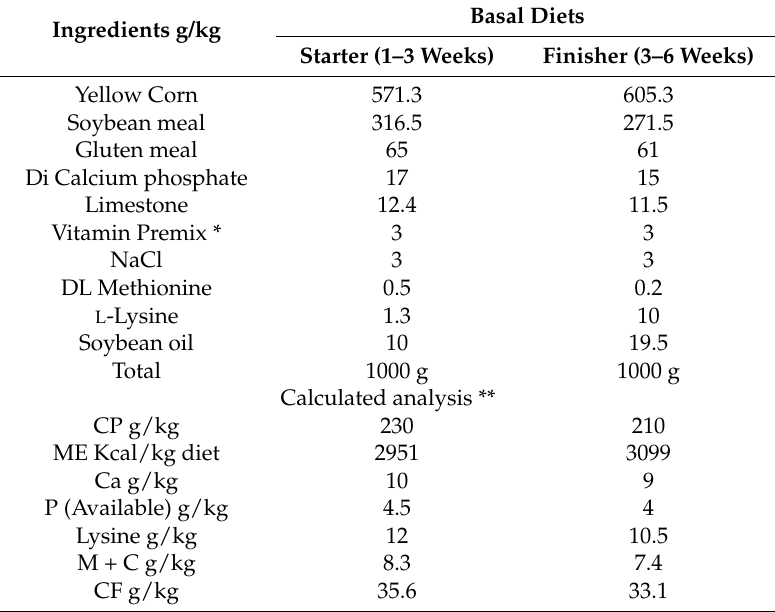
Table 7. Composition and chemical analysis of the basal